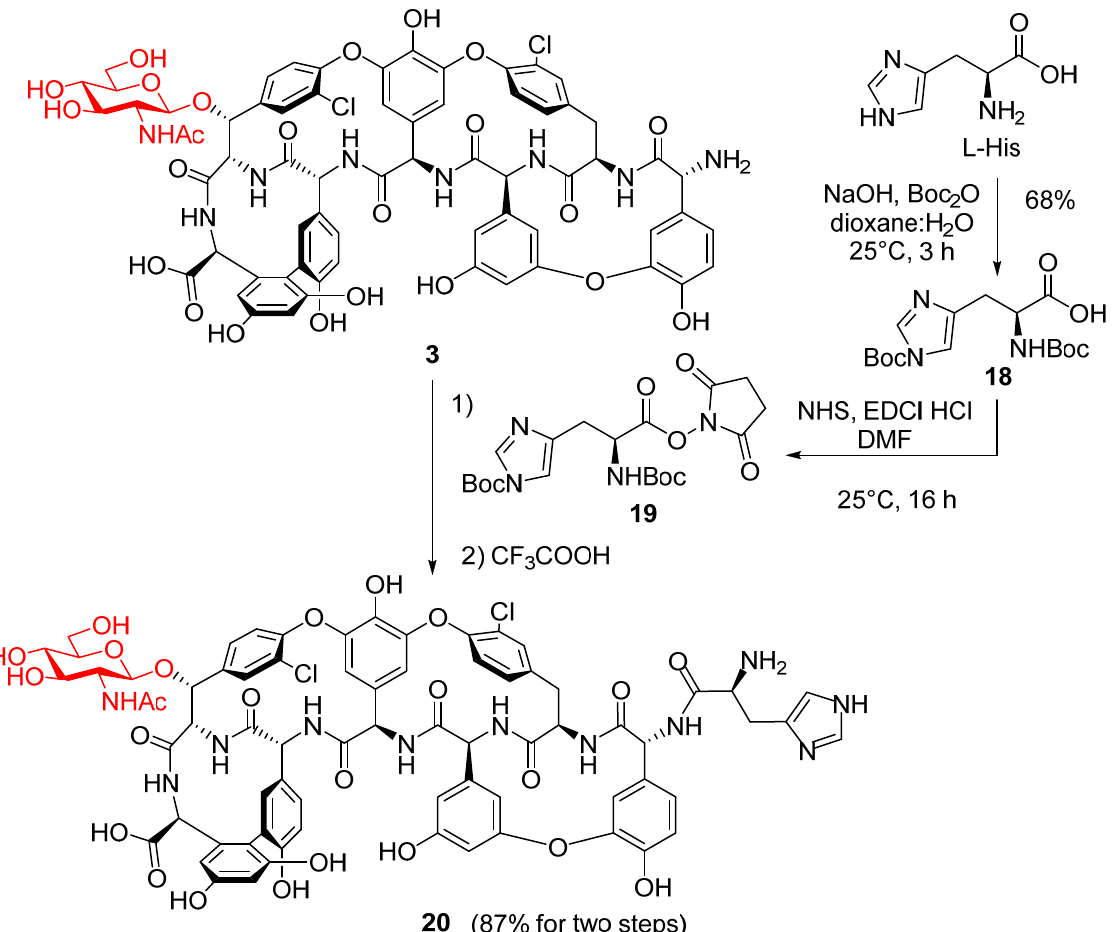
Figure 1. Structure of the Co(III) complex dimer obtained from 3